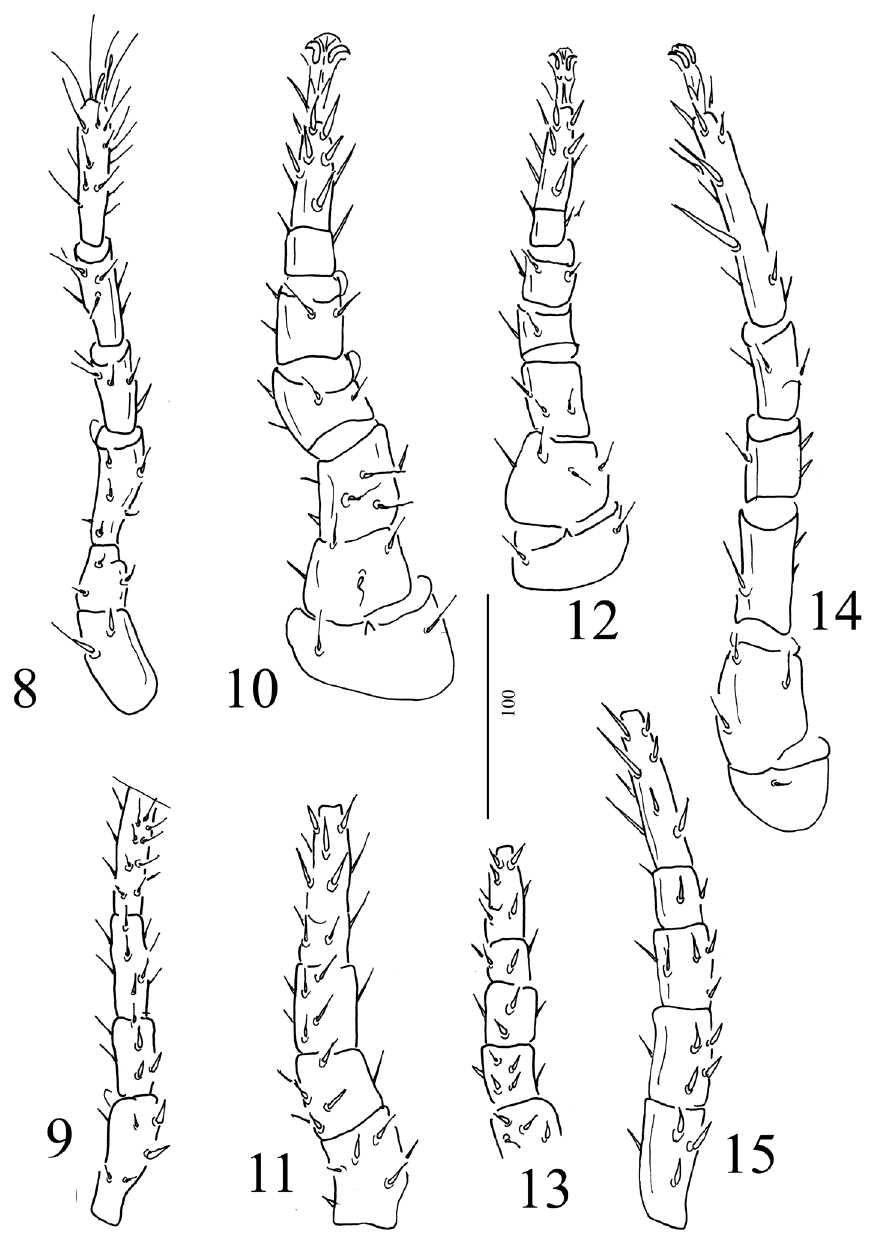
Figures 8–15. Macrocheles kekensis sp. n., female 8 Leg I in ventral view 9 Leg I in dorsal view 10 Leg II in ventral view 11 Leg II in dorsal view 12 Leg III in ventral view 13 Leg III in dorsal view 14 Leg IV in ventral view 15 Leg IV in dorsal